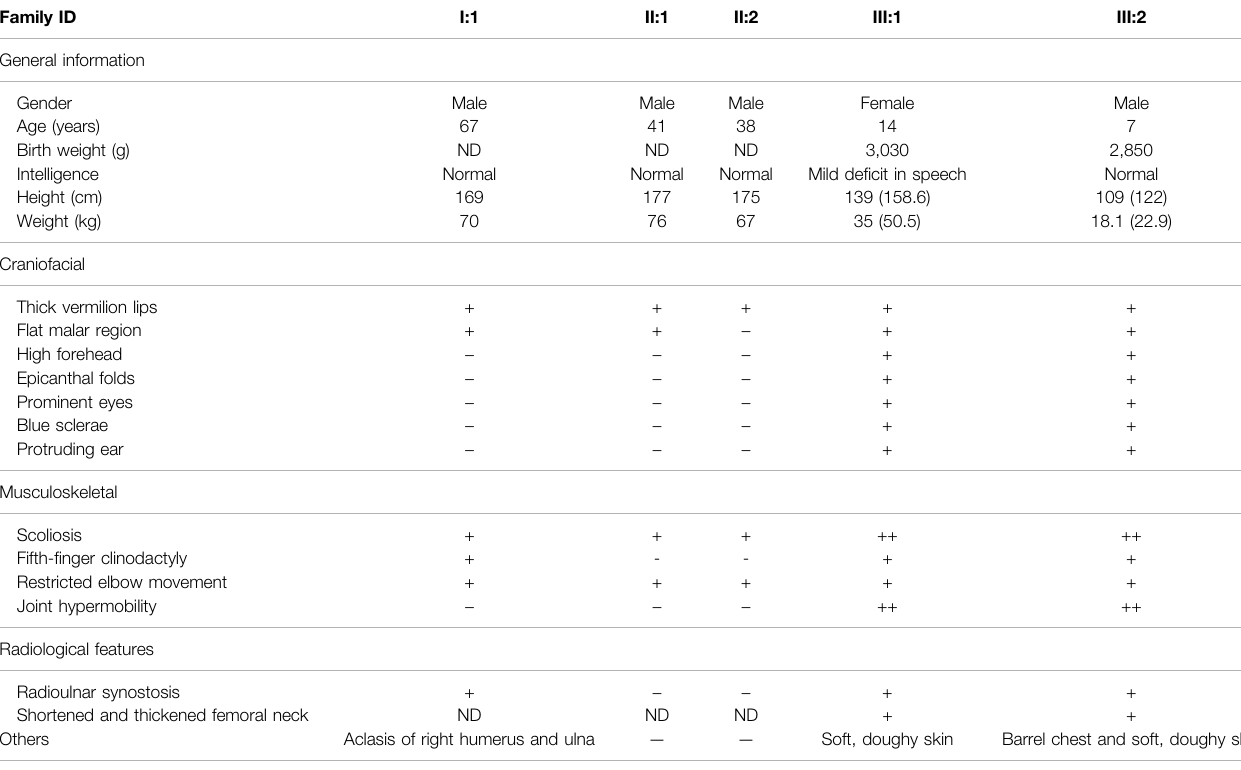
TABLE 1 | Manifestations and radiographic fi ndings of the individuals in the family. Family